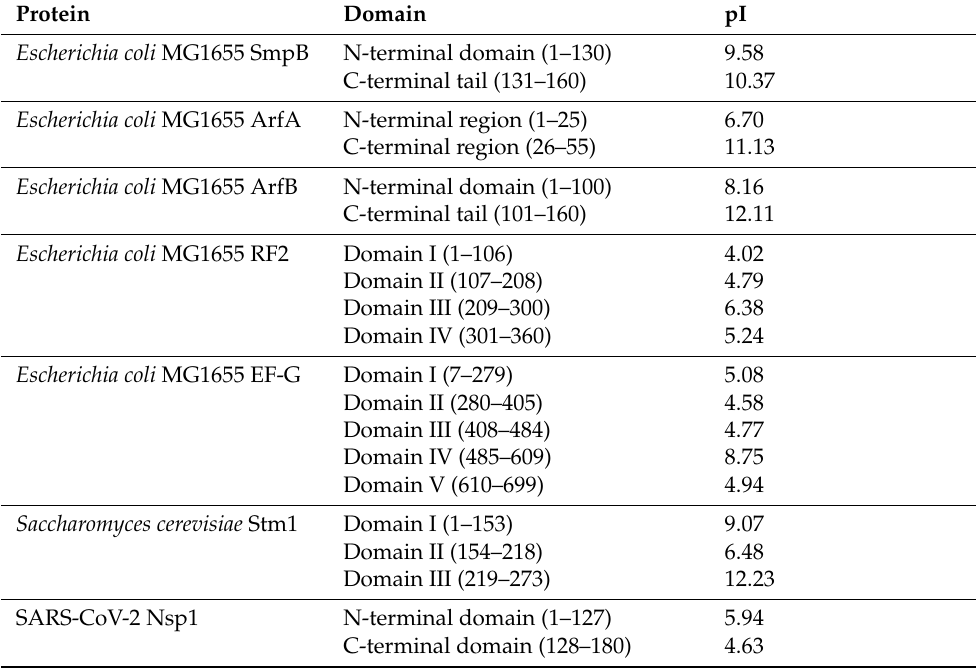
Table 1. Isoelectric point (pI) of protein